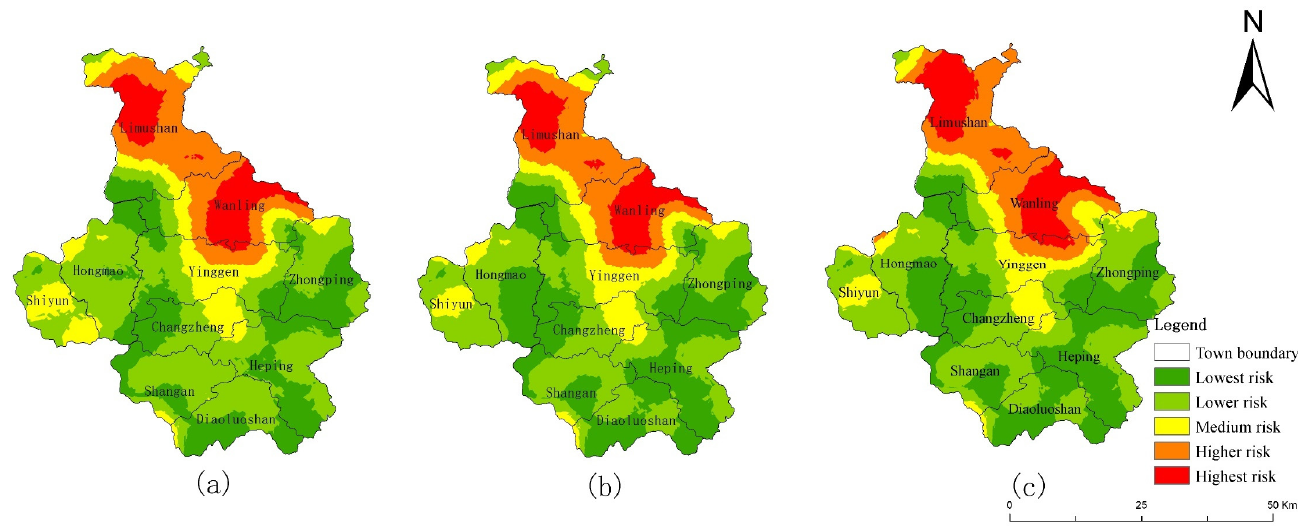
Figure 5. Spatial distribution of landscape ecological risk in Qiongzhong County. ( a ) 2000, ( b ) 2010, ( c ) 2018.